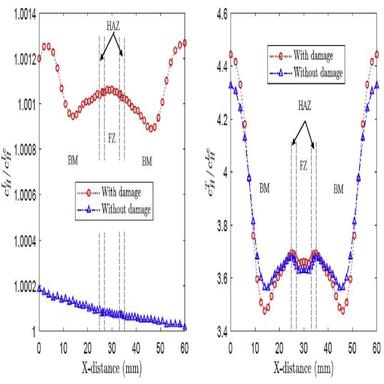
Damage effects on the normalized lattice cL H∕cLe H (on the left) and trapping cT H∕cLe H (on the right) hydrogen concentration.